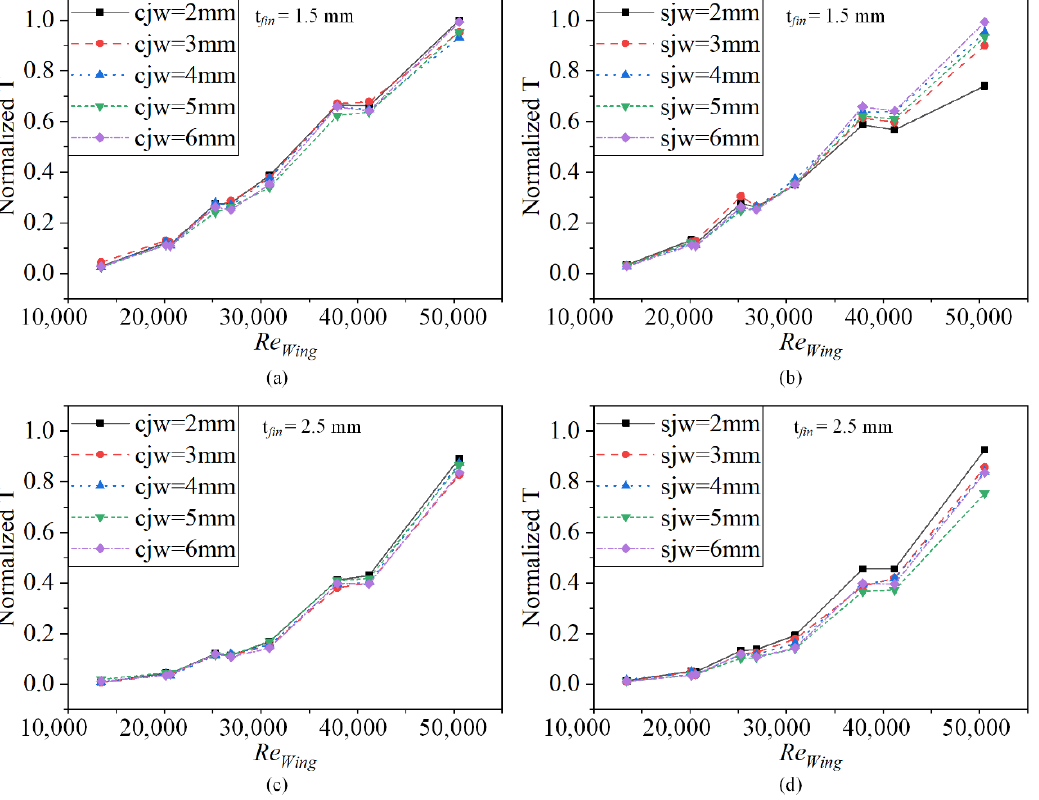
Figure 7. Variation of normalized T with Re Wing at various joint widths. ( a ) t fin = 1.5 mm, variation of Normalized T with Re Wing at cjw ; ( b ) t fin = 1.5 mm, variation of normalized T with Re Wing at sjw ; ( c ) t fin = 2.5 mm, variation of normalized T with Re Wing at cjw; ( d ) t fin = 2.5 mm, variation of normalized T with Re Wing at sjw .